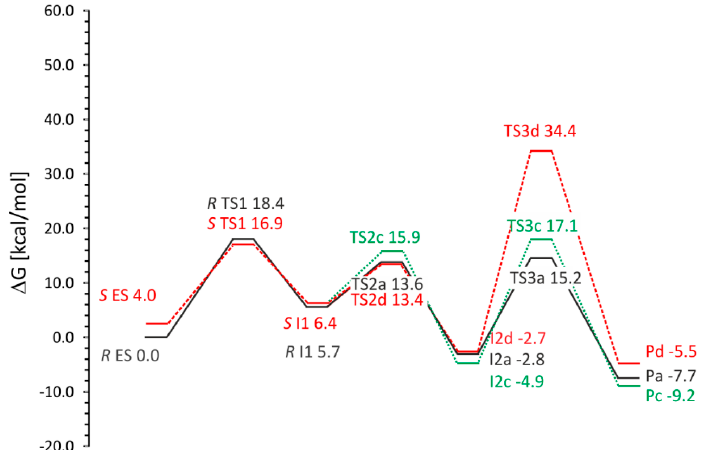
Figure 9. The Gibbs free energy profile obtained for pro( R ) pathway (a)—solid black line and pro( S ) pathways: (c)—dotted green line and (d)—dashed red line.